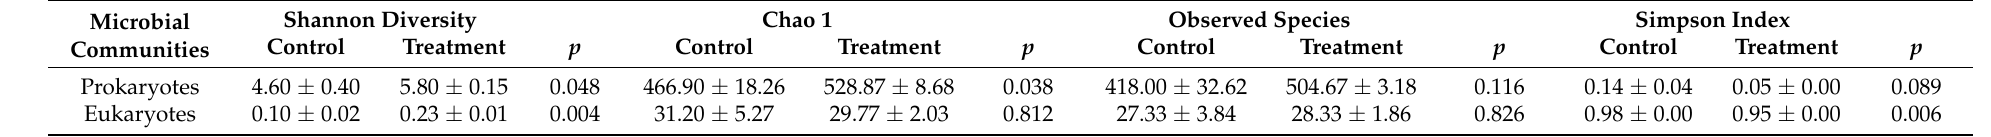
Table 2. Comparison of the α -diversity indices of larval microbial communities between control group and treatment